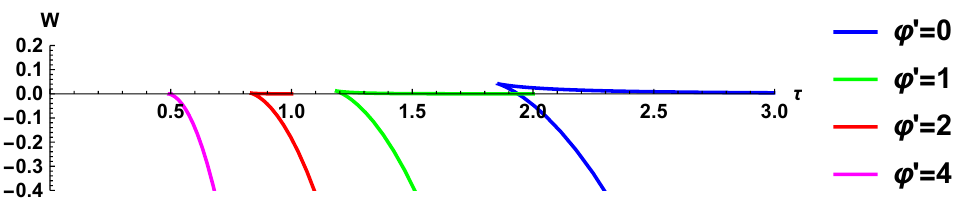
Figure 5 . The BPS free energy W versus the BPS temperature τ for various values of positive ϕ 0 . The small black hole branches (the upper branches) have W = 0 at their maximal temperature τ max (4.49). Upon increasing ϕ 0 starting from zero, the ( W cusp , τ cusp ) coordinates of the cusp both decrease. The Hawking-Page temperature τ HP where the large black hole branch has W = 0 also decreases with increasing ϕ 0